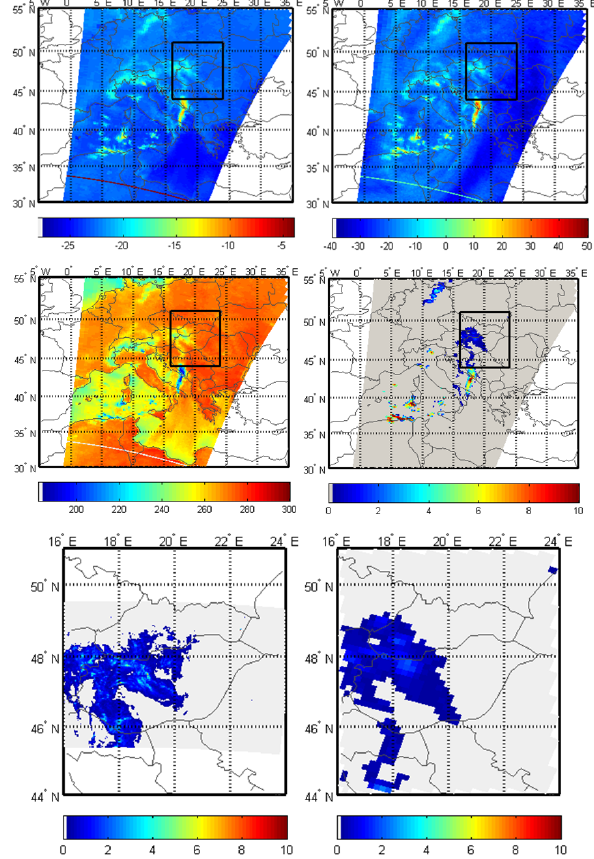
Figure 9. Stratiform precipitation over Hungary, 1 December 2009, 09:05UTC. Top panels: map of the input data to the NN, LCT (left) and (cid:49) 17 (right). Middle panels: map of MHS (MetOp-A) TB (K) at 150GHz (left), and PNPR surface precipitation rate (mmh − 1 ) (right) (rectangles show the approximate area covered by the radar measurements). Bottom panels: detail of radar rainfall rate estimates (mmh − 1 ) (for the area in the rectangles shown in top panels) ob- tained from the Hungarian radar network, at 09:00UTC (left), and PNPR surface precipitation rate (mmh − 1 ) at 09:05UTC